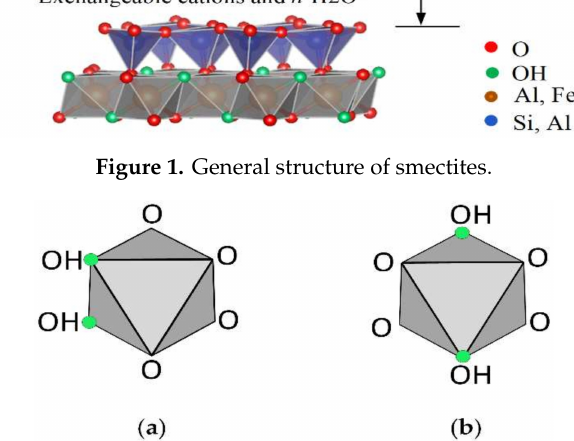
Figure 2. Structure of ( a ) cis -octahedron and ( b ) trans -octahedron.